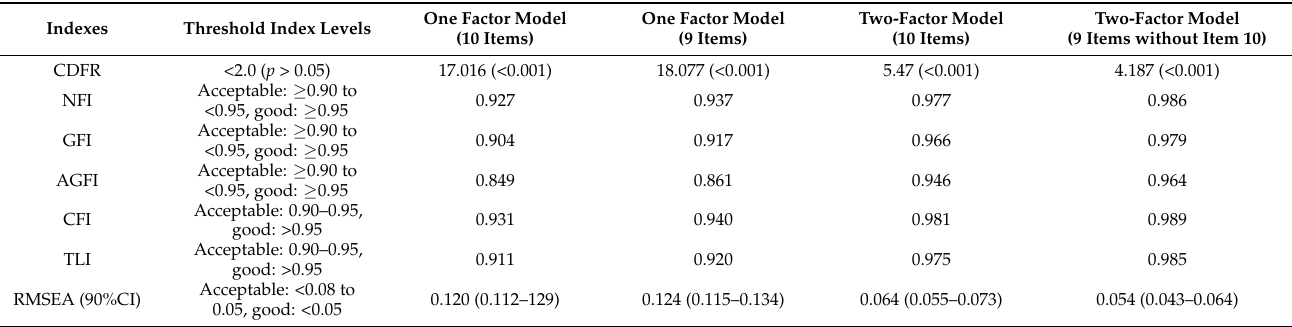
Figure 2. The CFA measurement model for the Polish version of the adult Vaccine Hesitancy Scale (PL-aVHS). Table 7. The fitting results of three models of the